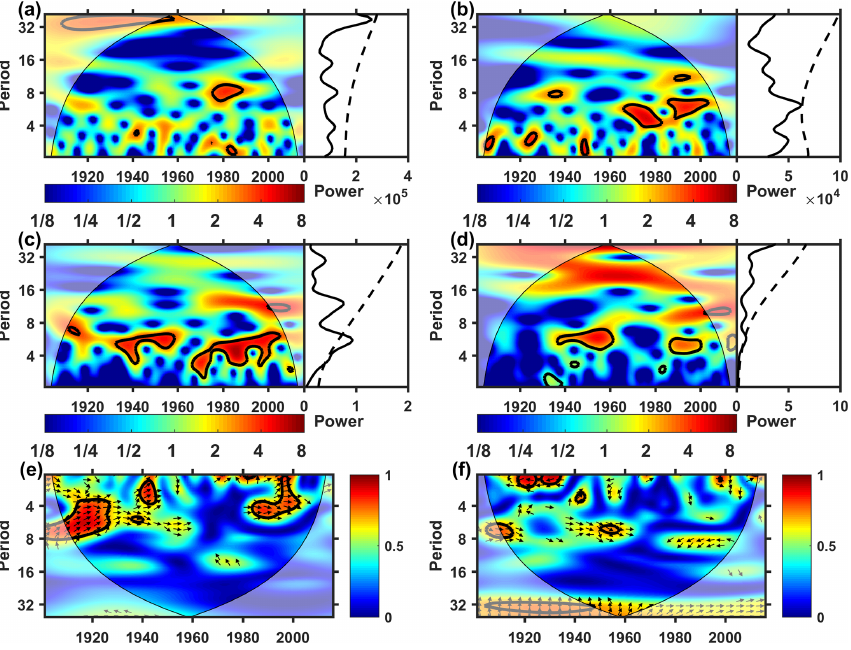
Figure 7. Wavelet spectra for the dry season. (a) PC1, (b) PC2, (c) Niño3.4 index, (d) PDO index, (e) wavelet spectral coherence of PC1 and Niño3.4 and (f) wavelet spectral coherence of PC2 and PDO. The global spectra are shown on the right side of the time-varying wavelet spectra and the black lines denote the statistical significance at the 95% confidence level.